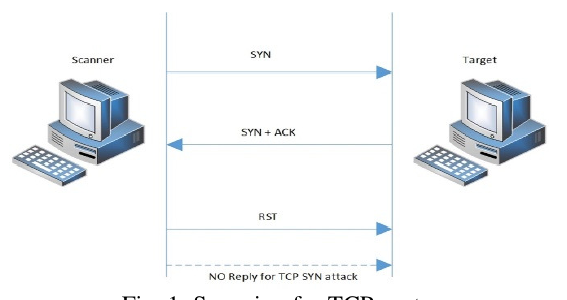
Fig. 1: Scanning for TCP ports.